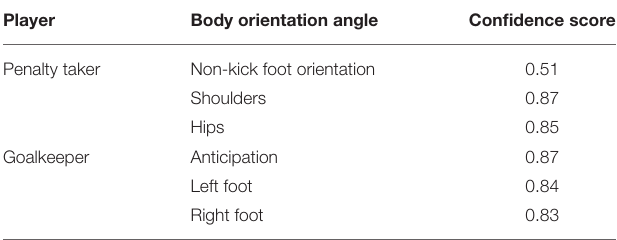
TABLE 5 | Association between OSPAF and OpenPose variables with the penalty taker